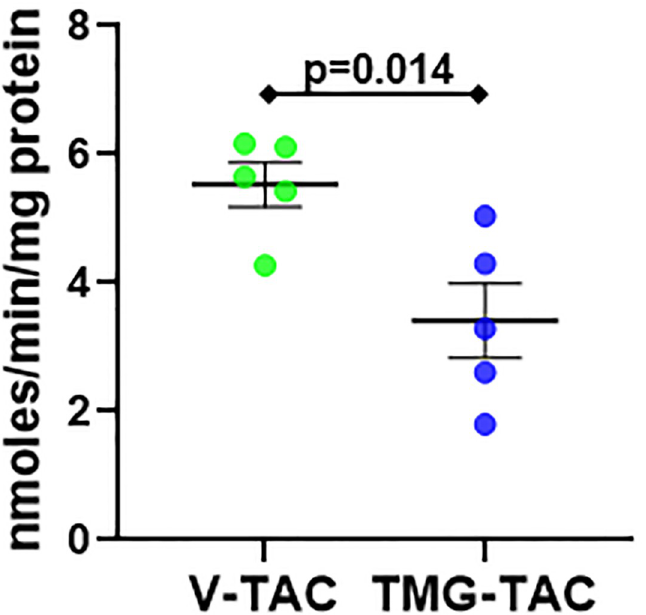
Fig 7. Quantification of enzyme activity for PDH in experimental groups V-TAC versus TMG-TAC. Bars indicate mean ± standard error of the mean. N = 5 per group.